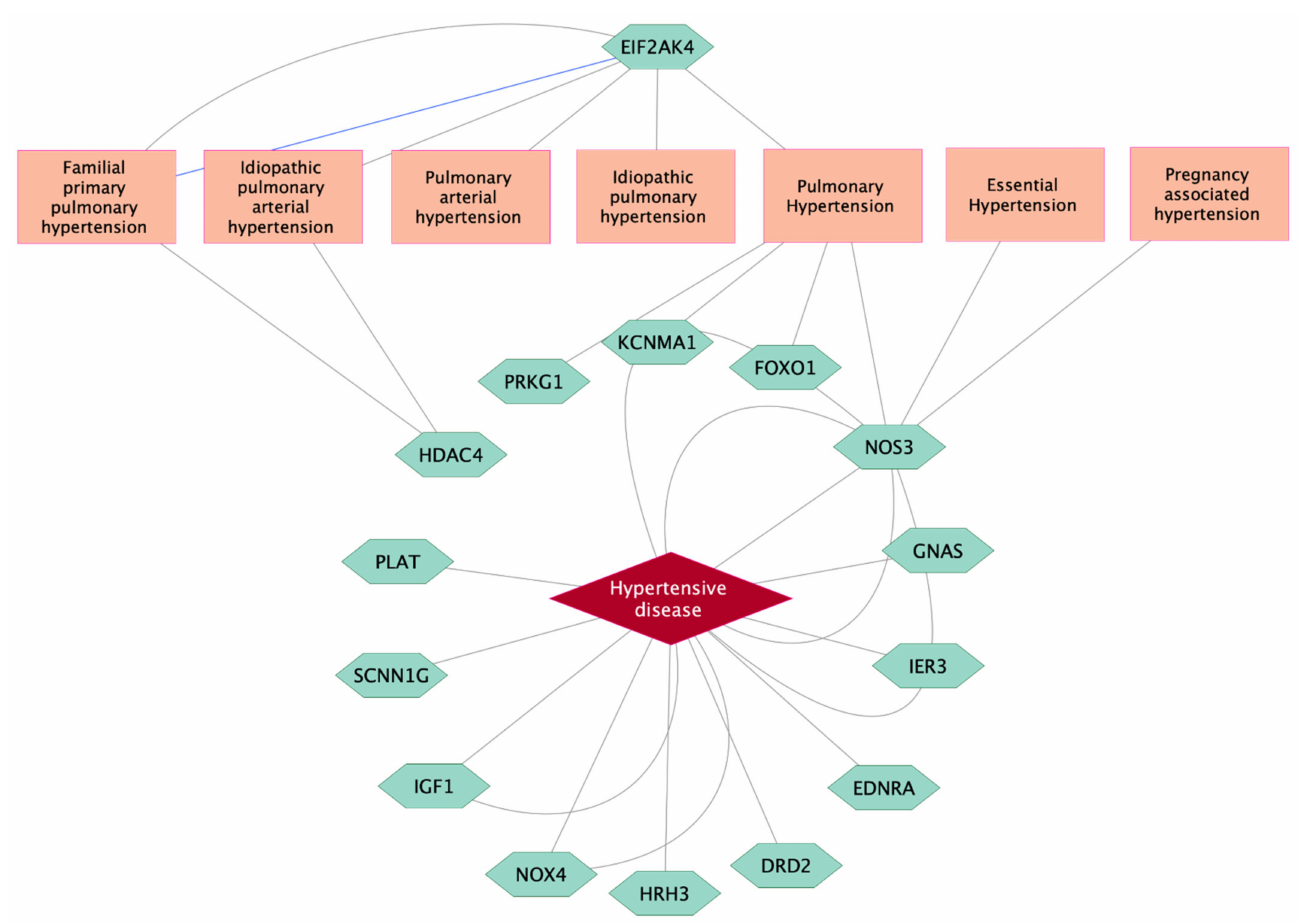
Figure 3. Target genes as significant biomarkers for high BP-related diseases using a curated database in the DisGeNet platform. Grey lines link gene expression biomarkers for target disease, while blue line links genetic variation for target